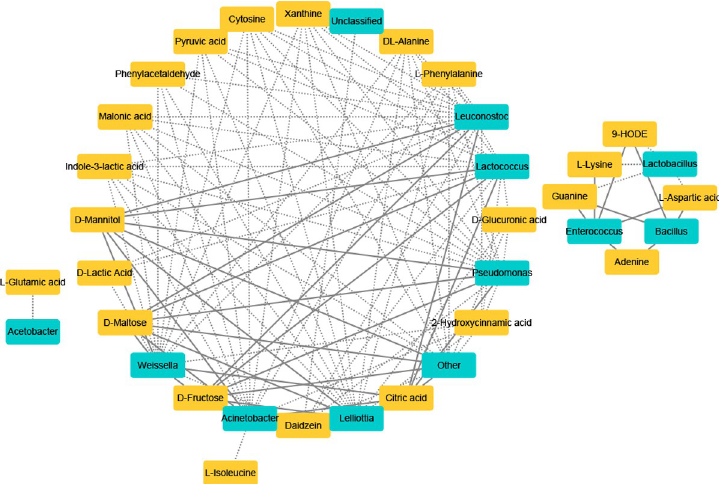
Fig 7. Spearman correlations between metabolites by LC-MS analysis and main bacteria species. Differentially expressed metabolites during fermentation were screened by PLS-DA; Positive correlations are indicated with solid lines (R > 0.90) and negative correlations are shown by dashed lines (R < -0.90).